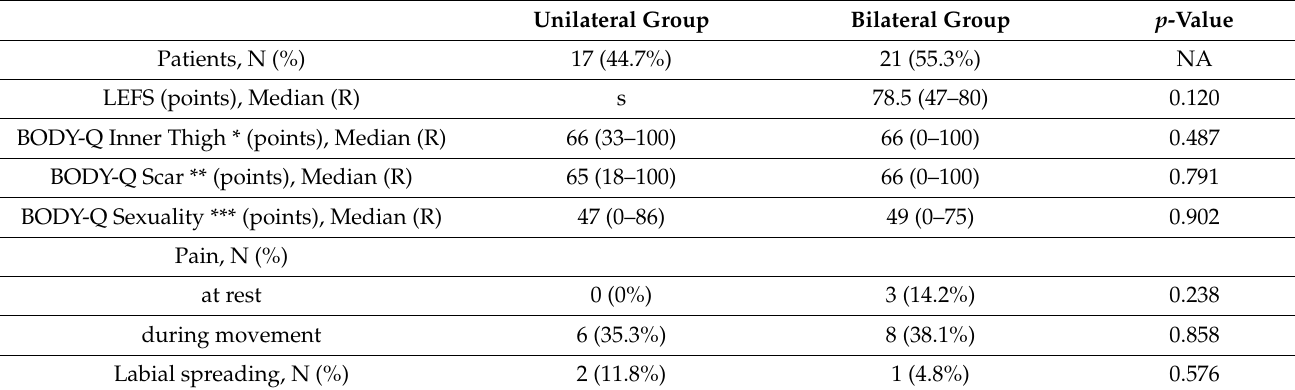
Table 5. Patient-reported outcome